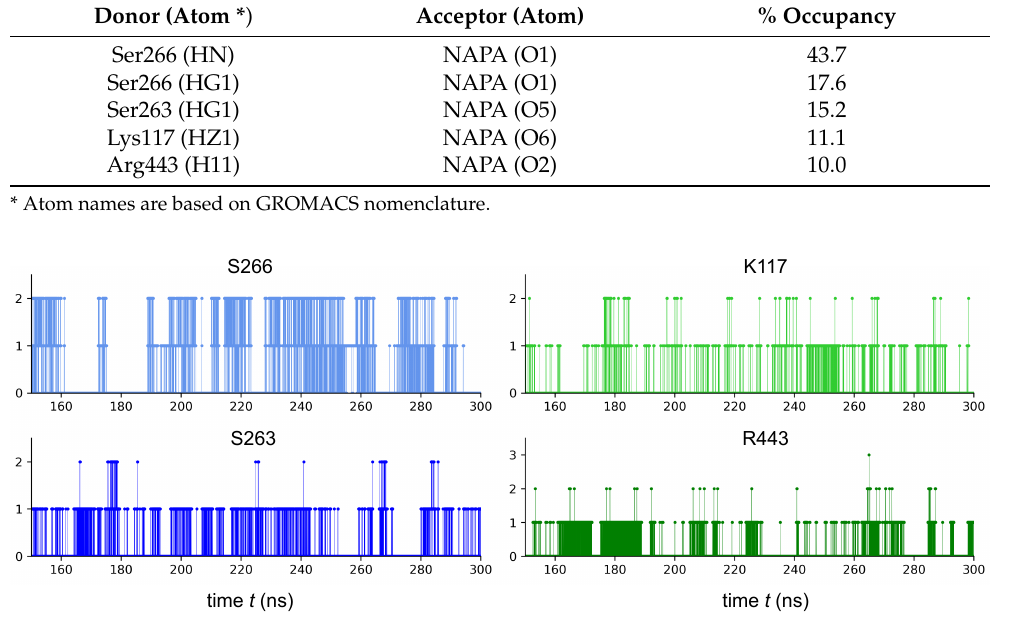
Figure 9. Evolution during the MD simulation (from 150 to 300 ns) of H-bonding network found in IKK α -NAPA complex. We reported H-bond evolution for residues of BS1 showing the top 5